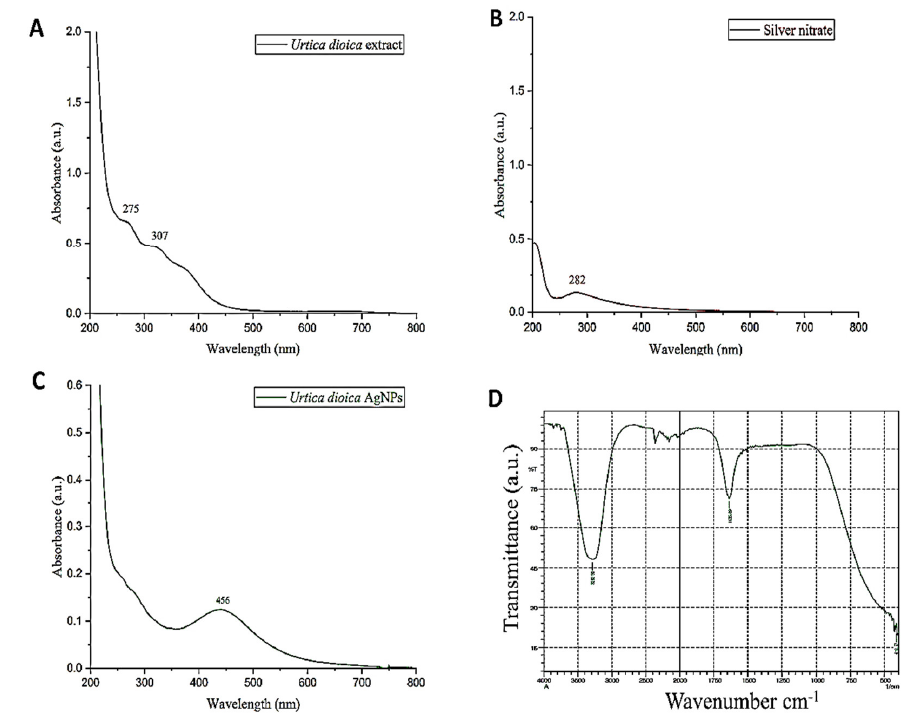
Figure 4. UV–visible spectra of Urtica dioica extract ( A ), silver nitrate ( B ), and biosynthesized nanoparticles of UD ( C ) in the absorption spectrum of 200–800 nm. The functional groups of Urtica dioica leaf extract responsible for the formation and stability of silver nanoparticles (UD-AgNPs) were investigated using FTIR ( D ) with a scan range of 400–4000 cm −1 .